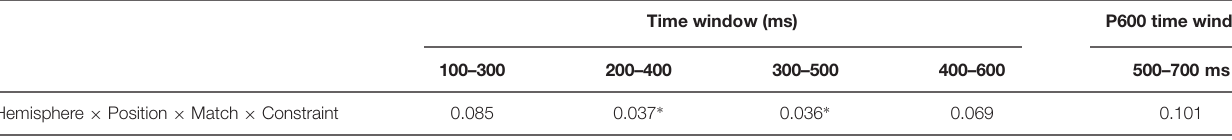
TABLE 1 | Multiple window ANOVA 4-way interaction results ( p -values